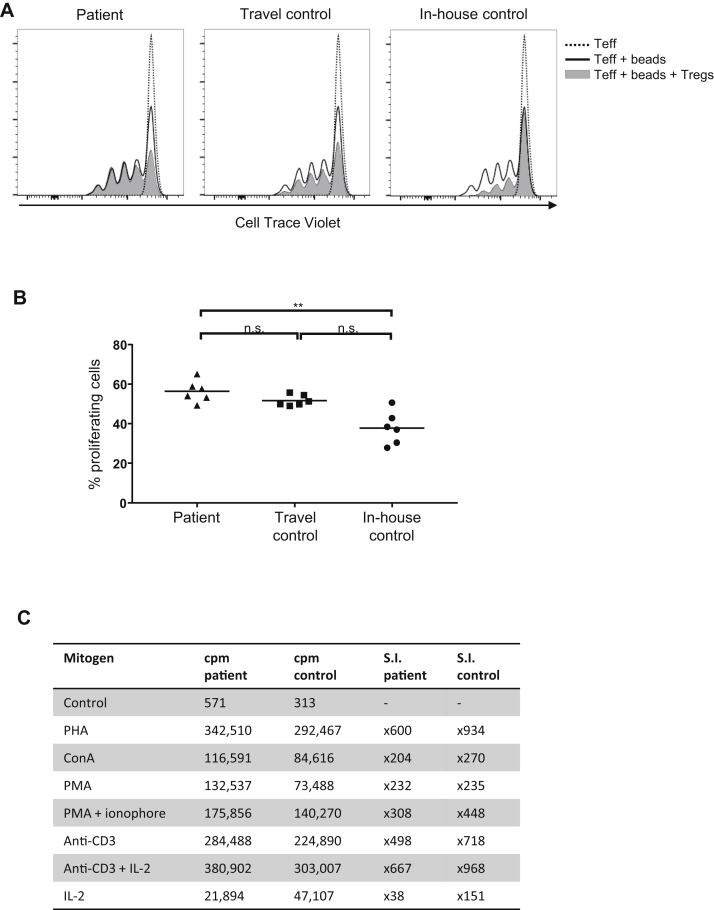
A, Treg-cell suppression assay. Dotted line: Teff alone. Solid line: Teff stimulated with Treg-cell inspector beads. Shaded area: Teff stimulated with Treg-cell inspector beads in the presence of Treg cells. Proliferation of Cell trace violet-labeled Teffs was measured as dilution of the dye with every cell division. Inhibition of Teff proliferation by Treg cells is shown by reduced dye dilution. Results are shown for the patient, a travel control (both performed with 36-hour-old blood), and an in-house control (fresh blood). B, Percentage of proliferating cells with means of 6 replicates given. Patient's Treg cells showed significantly reduced suppressive capacity compared with those of the in-house (**Kruskal-Wallis-Test: P = .0021) but not those of the travel control. C, Lymphocyte proliferation, measured as counts per minute (cpm) of incorporated tritiated thymidine, was normal to all mitogens tested. ConA, Concanavalin A; n.s., nonsignificant; PMA, phorbol myristate acetate; S.I., stimulation index.